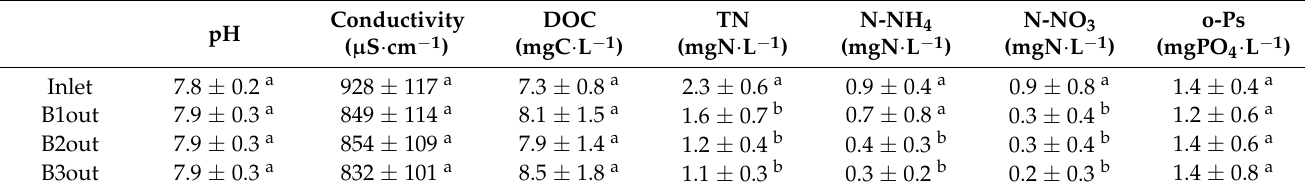
Table 2. Water quality at the inlet and the three outlets (B1out, B2out and B3out). Values to the right of ( ± ) are the standard deviations. Values with different superscript letters (a, b) within each parameter are significantly different ( p < 0.05) ( n =